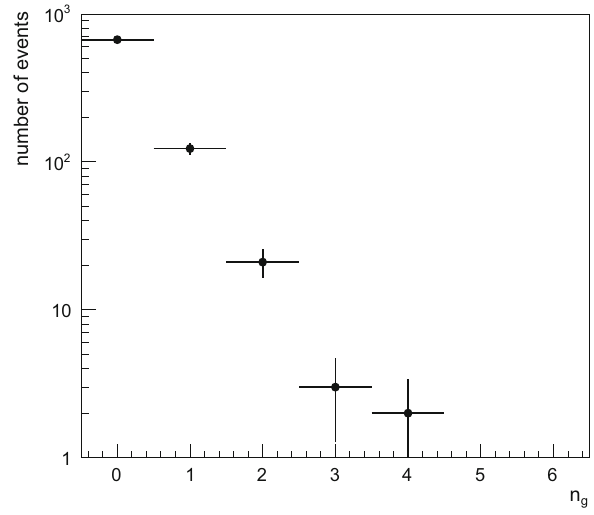
Fig. 4 Multiplicity distribution of grey tracks